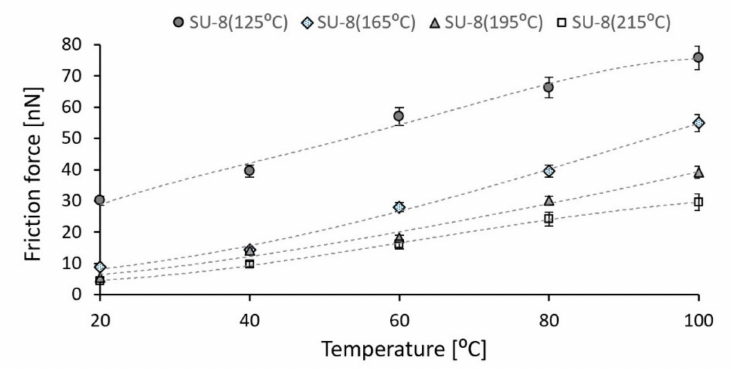
Figure 11. Friction force variation between AFM tip and SU-8 polymers as a function of the testing temperature (error amount percentage less to